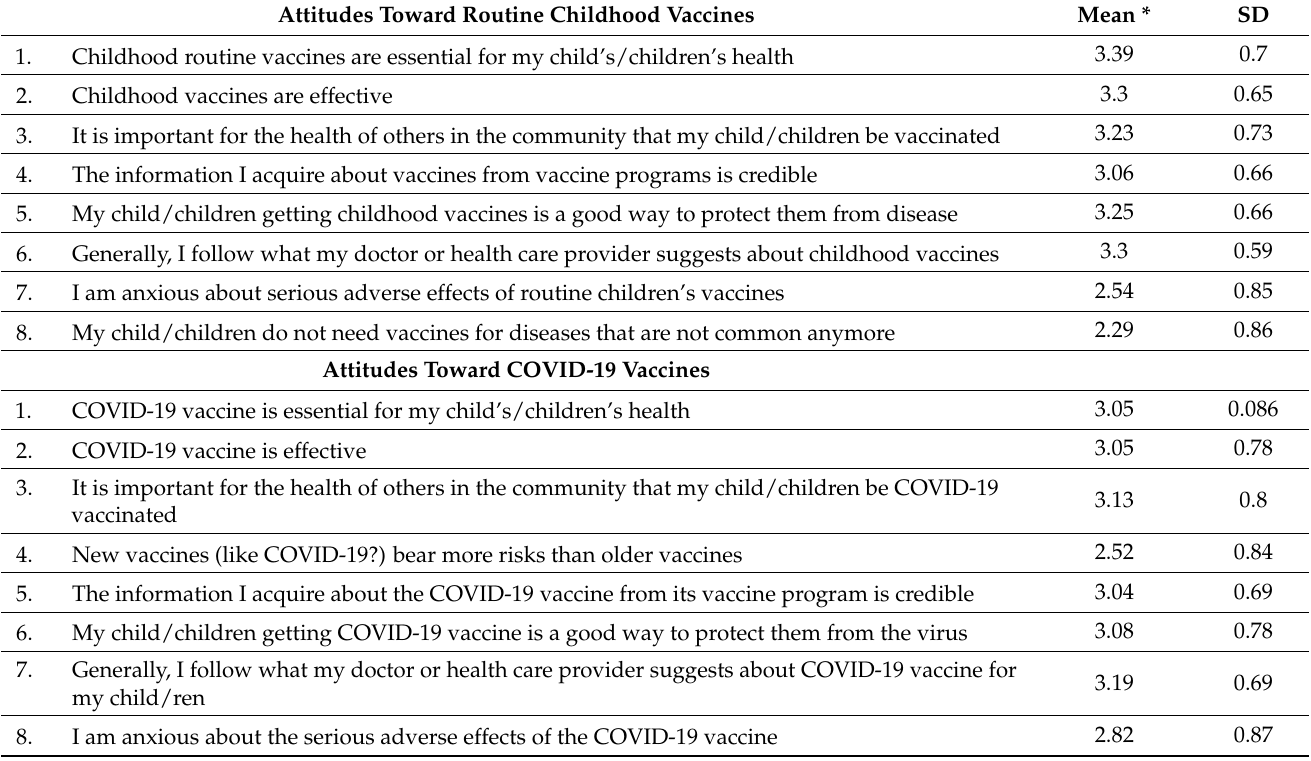
Table 3. Parental attitudes toward children’s COVID-19